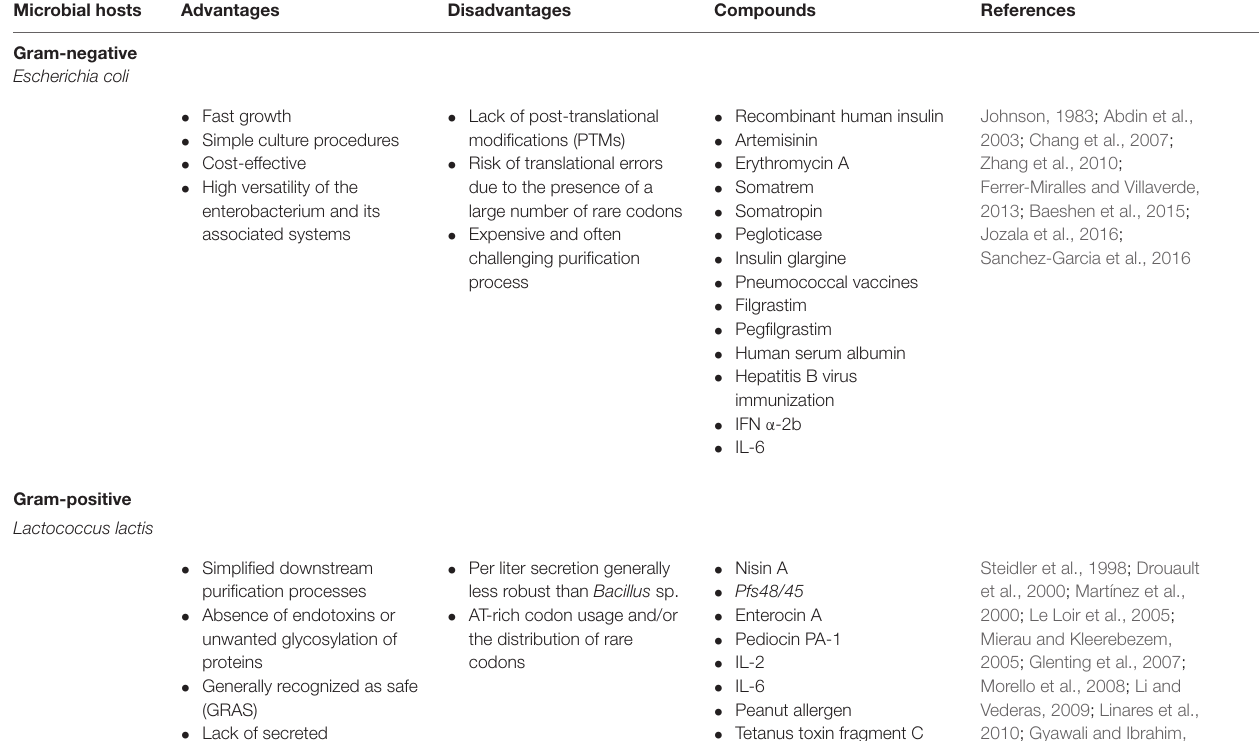
TABLE 2 | Comparison between different microbial host systems for production of recombinant proteins and natural products. Microbial